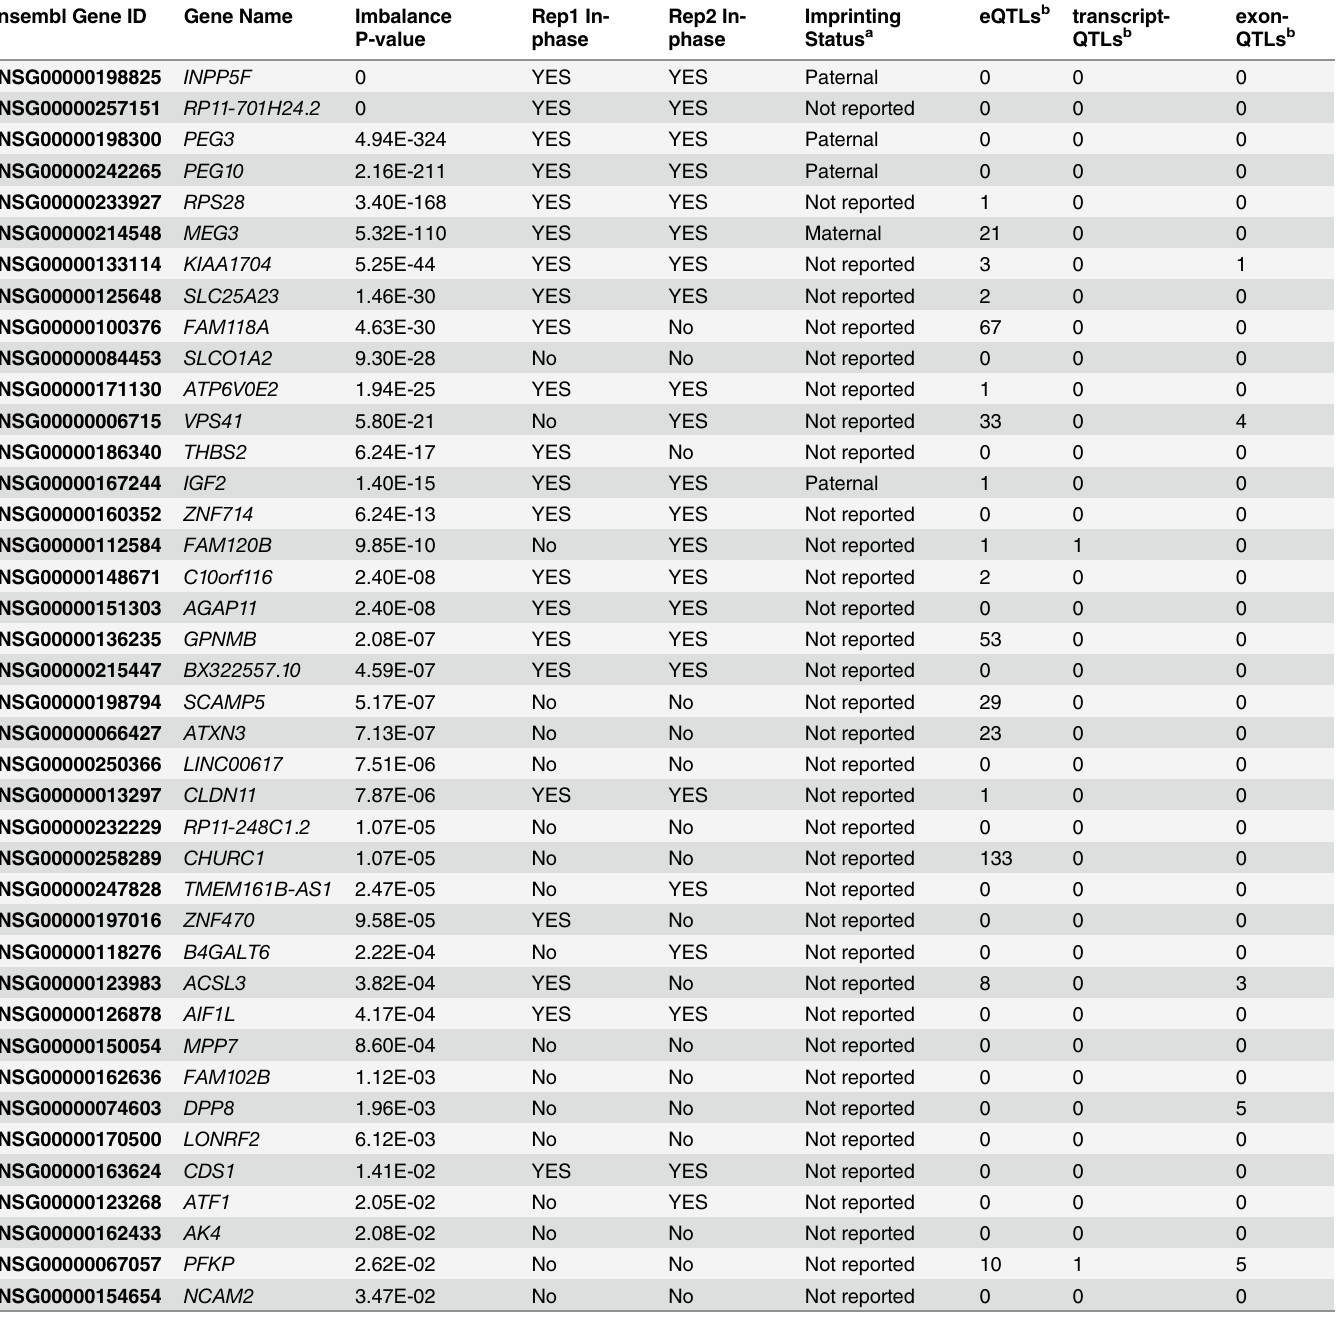
Table 1. Top ASE genes from the brain tissue sample. Ensembl Gene